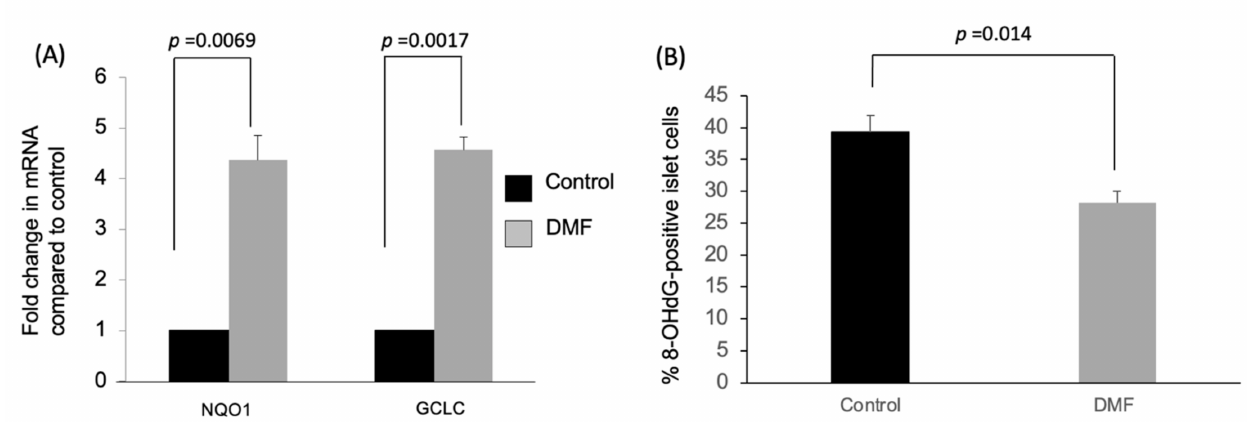
Figure 2. Impact of treatment with DMF on antioxidant enzymes and oxidative damage in isolated islet cells. ( A ) Effects of DMF administration on mRNA levels of antioxidant enzymes in the isolated islets were evaluated by qRT-PCR. Both GCLC and NQO1 mRNA expression of the isolated islets ( n = 3 each group) in the DMF-treated group were four-fold higher compared to control group. ( B ) Immunofluorescent staining of the 8-OHdG was performed to evaluate oxidative stress in dissociated islet cells. 8-OHdG-positive islet cells ( n = 4 for each group) were significantly decreased in the DMF-treated group compared to the control group ( p =